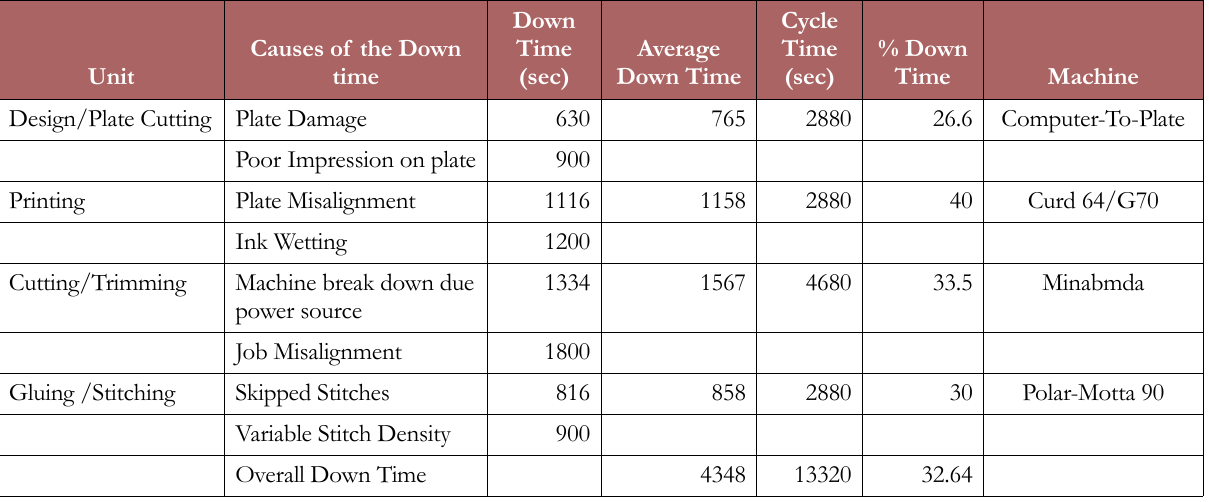
Table 5. Estimation of Percentage Down-Time in AB Production line